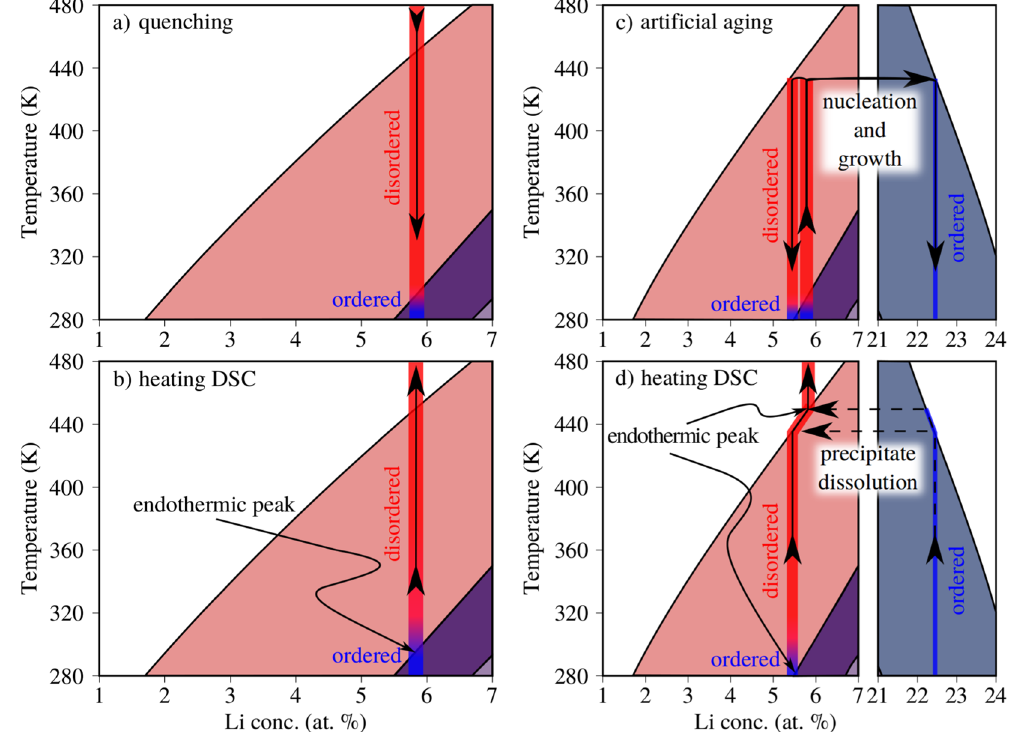
Figure 8. Reaction pathway of the sample during quenching from solution annealing temperature ( a ) and during subsequent slow heating from room temperature as performed in the DSC ( b ), as well as during annealing at 433 K with subsequent quenching to room temperature ( c ) and during subsequent slow heating from room temperature as performed in the DSC ( d